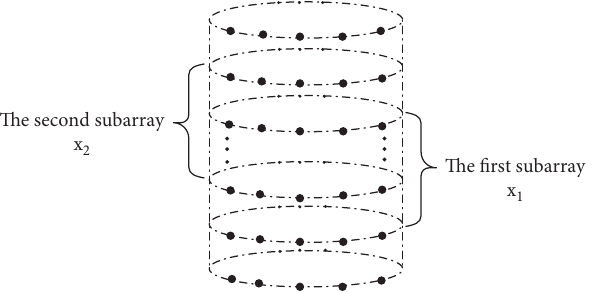
Figure 3: Spatial structure of